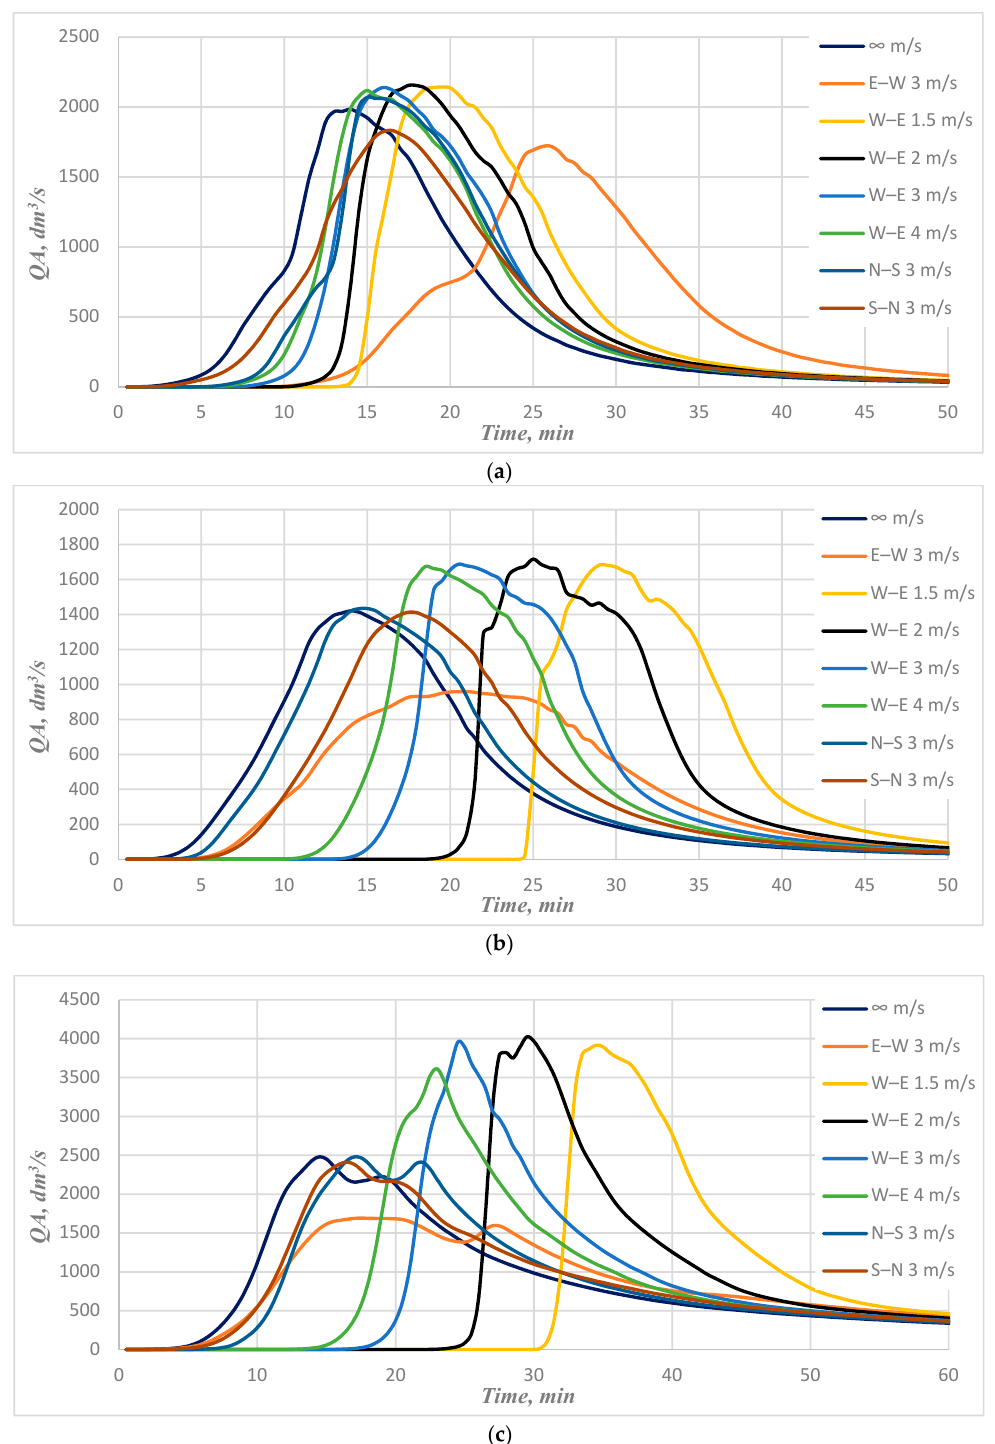
Figure 5. ( a ) Hydrographs of the stormwater flow rate Q A for tank DT1 at the specific duration of rainfall t d = 10 min, ( b ) hydrographs of the stormwater flow rate Q A for tank DT2 at the specific duration of rainfall td = 10 min, ( c ) hydrographs of the stormwater flow rate Q A for tank DT3 at the specific duration of rainfall td = 10 min and diameter of the outflow channels from tanks DT1 and DT2 equal Do = 0.3 m.